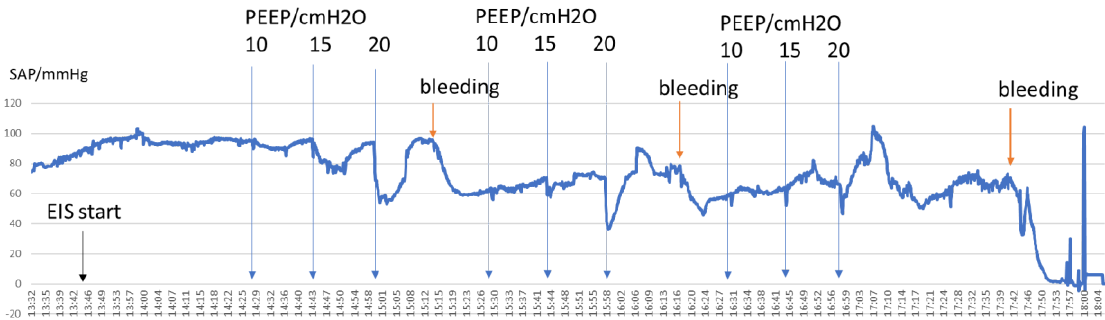
Figure 1. Mean arterial pressure (SAP) during the recoding and challenges (bleeding and PEEP). Y-axis is in mmHg; X-axis is clock time. EIS recording stated at 13:43.